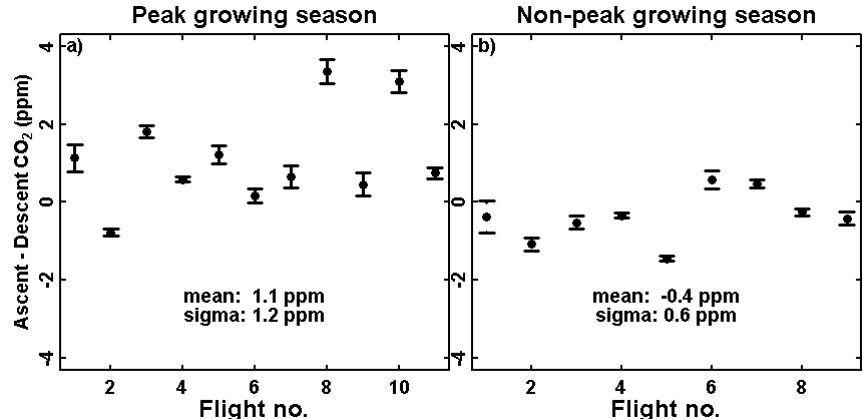
Fig. 14. Differences of mixed-layer CO 2 averages between the ascending and the descending profiles near Bialystok: (a) for the profiles made during the peak growing season; (b) for the profiles made during the non-peak growing season. The data were collected during 2008 and